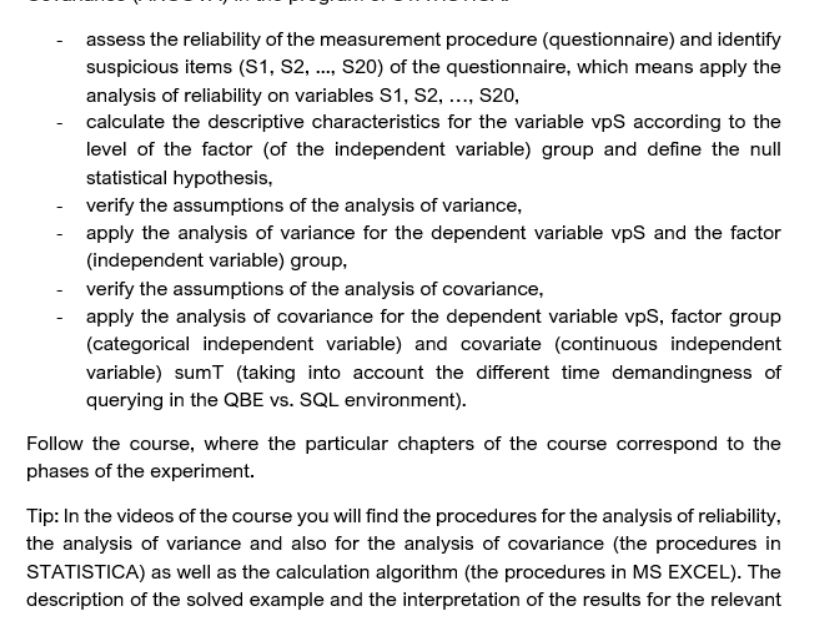
Figure 3. Example from the project assignment for the experimental group (posttest).